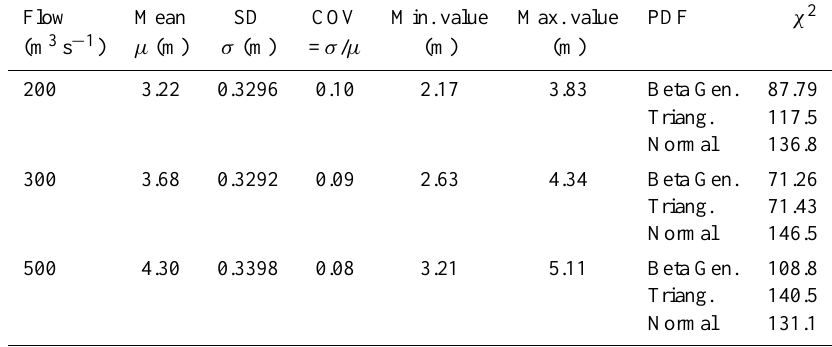
Table 4. Uniform flow model. Adaptation of PDFs to water depth with normal distributions for n i (1000 simulations). Flow